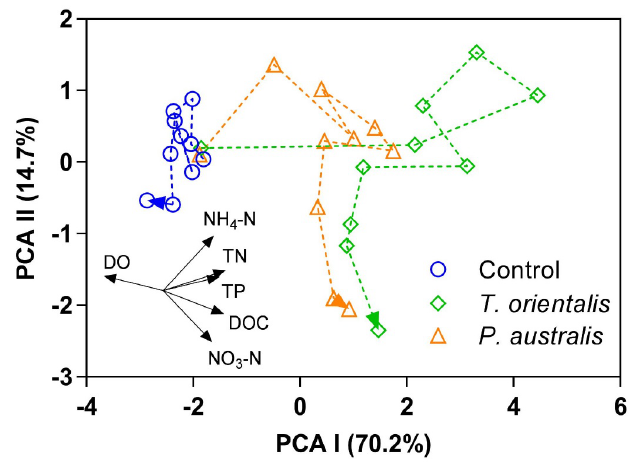
Figure 5. Principal component analysis (PCA) on water-quality dynamics through the experimental period: the dashed arrow indicates the succession of water quality from 0 to 120 days.